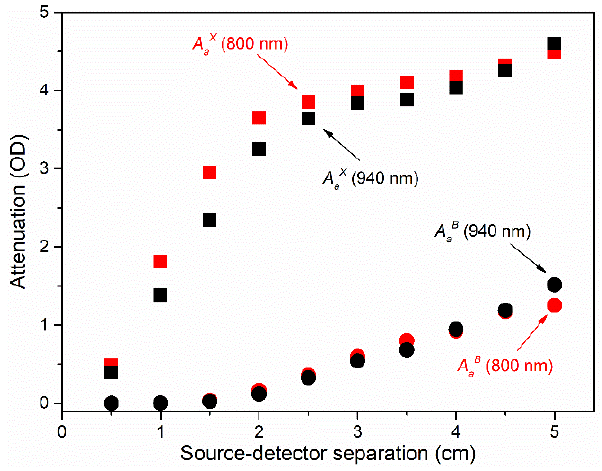
Figure 7. Optical attenuation A i a vs. SDD computed by MC simulation in the planar layer model for the extracerebral tissue layers (circles) and brain tissue layers (squares) and for wavelengths of 800 nm (red) and 940 nm (black).